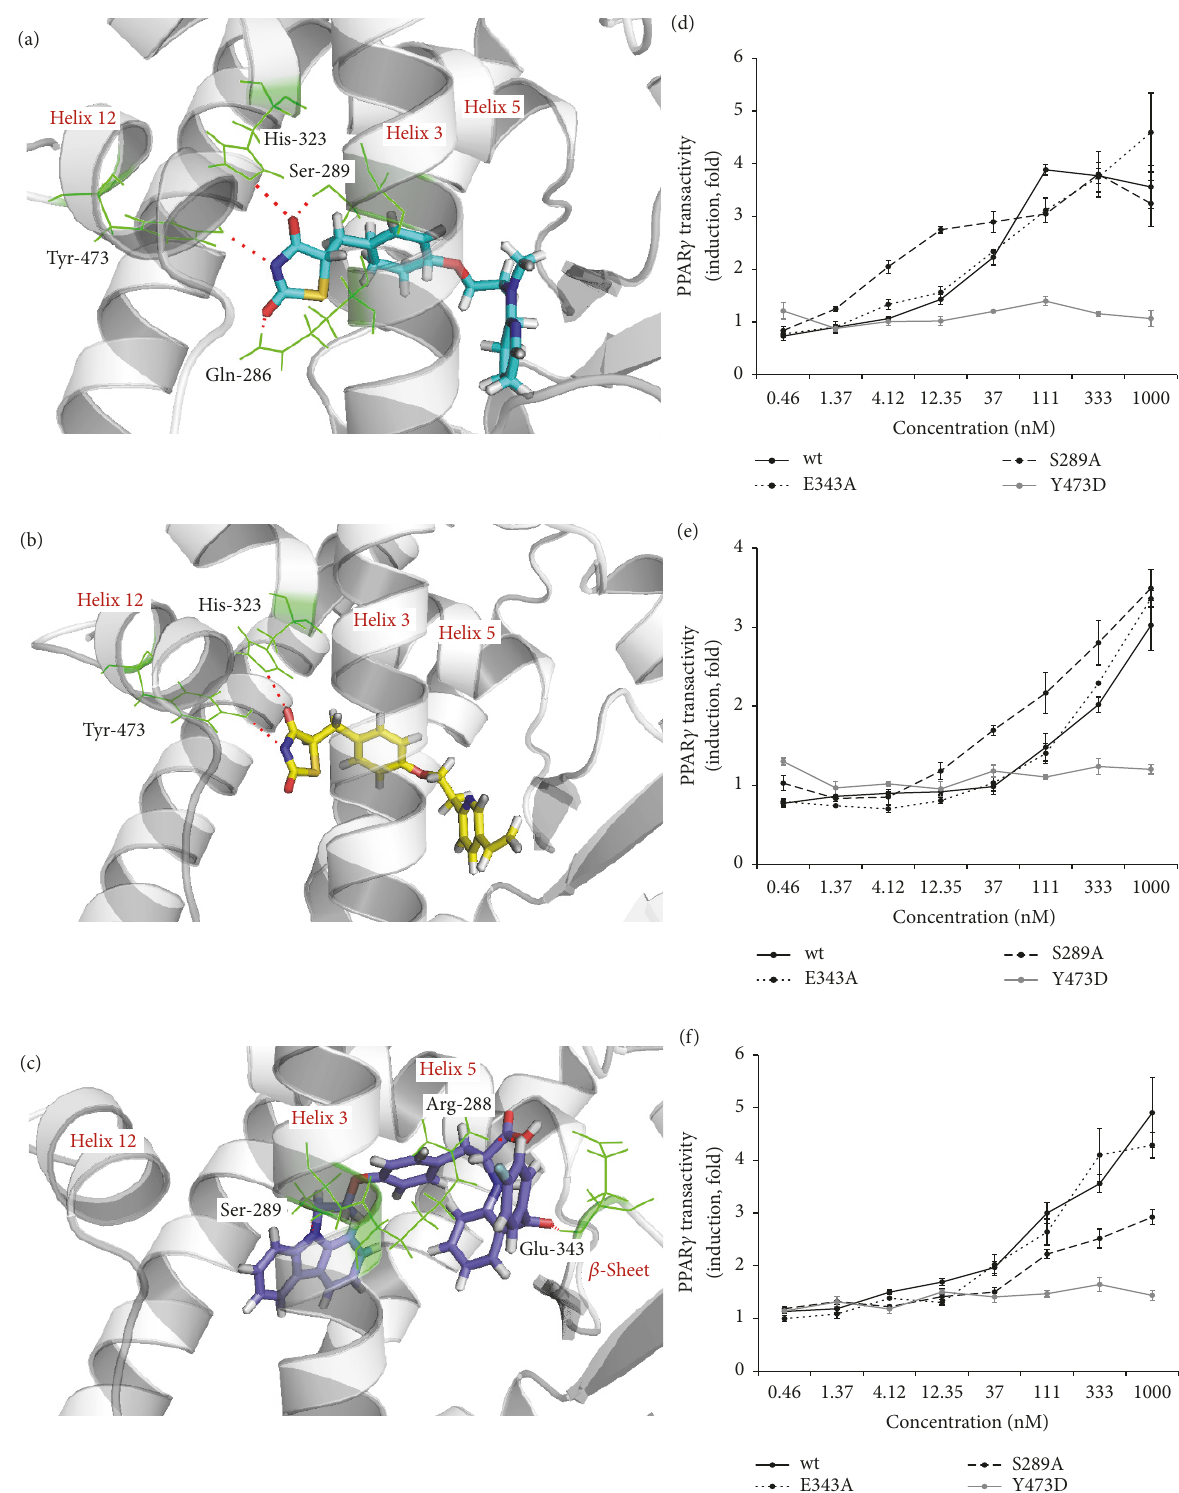
Figure 3: Chiglitazar binds PPAR 𝛾 differently from rosiglitazone and pioglitazone. (a)–(c) Simulated molecular docking of each agonist to the crystal structure of PPAR 𝛾 (PDB code: 2PRG, 2XKW as shown in gray) was performed using Molegro Virtual Docker software. Ros ((a), in cyan, docking to 2PRG) and Pio ((b), in yellow, docking to 2XKW) have typical modes of interaction with the receptor via hydrogen bonding to helix 12 (Tyr-473) and helix 5 (His-323) (residues in green, hydrogen bonds shown in dotted red lines). In this conformation, helix 12, along with helices 3–5, forms the coactivator-binding site (AF-2) responsible for full agonist activity. Chi ((c), in blue, docking to 2XKW) does not form typical hydrogen bonding to helices 12 and 5 but rather forms alternative hydrogen bonds to helix 3 and the receptor 𝛽 -sheet (residues in green). This conformation is highly similar to the partial agonist MRL-24. (d)–(g) Site-directed mutation of PPAR 𝛾 differently affects transactivity of different agonists (Ros (d), Pio (e), and Chi (f)) compared with wild-type receptor by reporter gene assay. PPAR 𝛾 with site-directed mutation at Y473D, E343A, or S289A, respectively, was constructed and applied in reporter gene assay as described in Materials and Methods